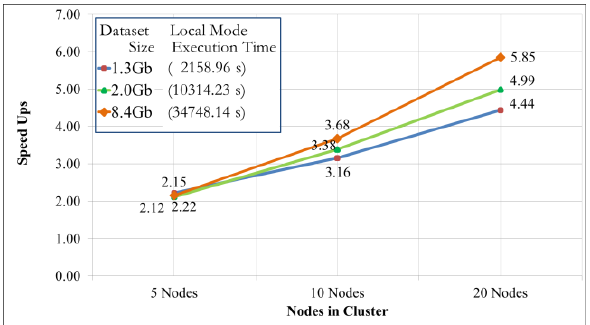
Figure 8. Speedups for the EM distributed clustering